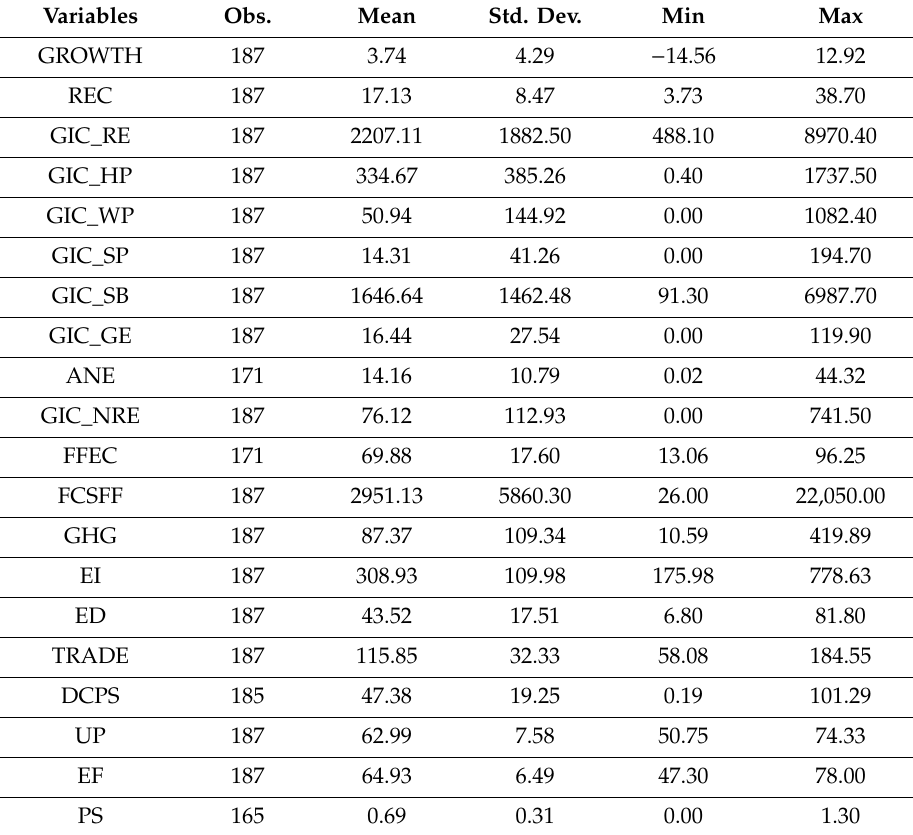
Table 3. Descriptive statistics (raw data).